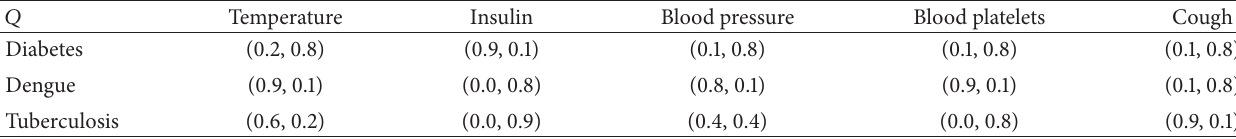
Table 4: Intuitionistic fuzzy relation 𝑄(𝐷 → 𝑆) .